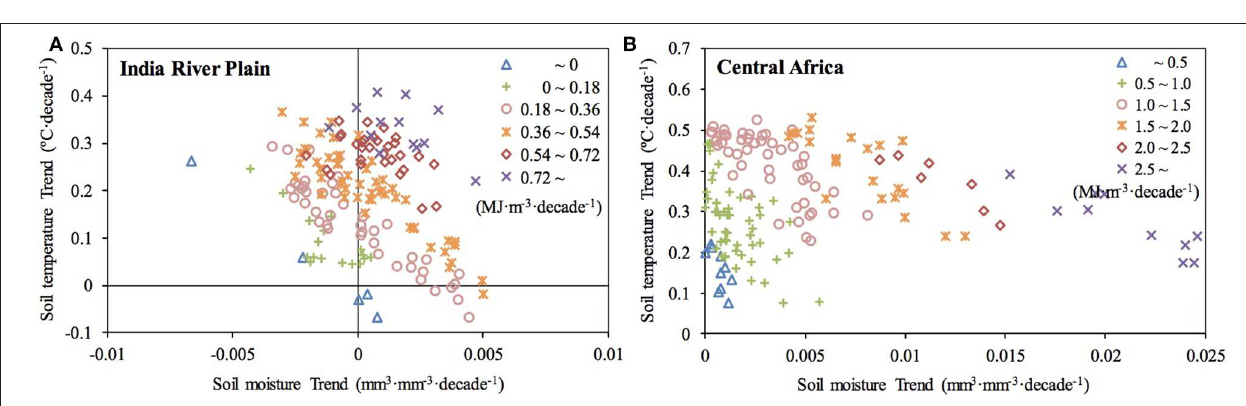
FIGURE 11 | Trends of soil enthalpy vs. soil moisture and soil temperature trends over (A) IP and (B) CA using